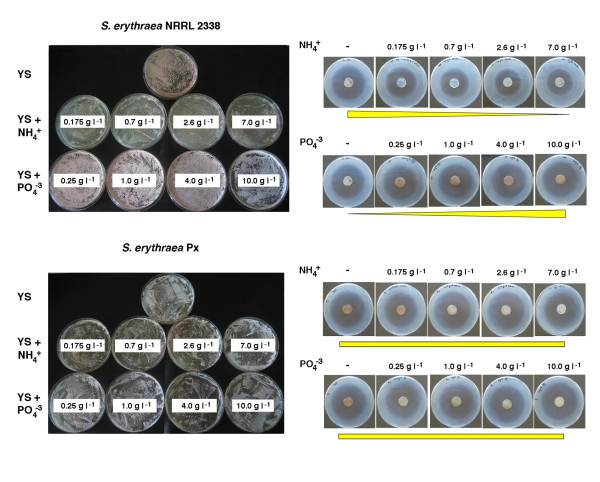
Effect of ammonia and phosphate on growth, pigmentation, sporulation and antibiotic production. S. erythraea NRRL 2338 and S. erythraea Px were cultivated for 7 days on YS agar supplemented with the indicated ammonia and phosphate concentrations (left panels). Antibiotic production in these media was evaluated by microbiological assay using Micrococcus luteus as a tester organism (right panel)